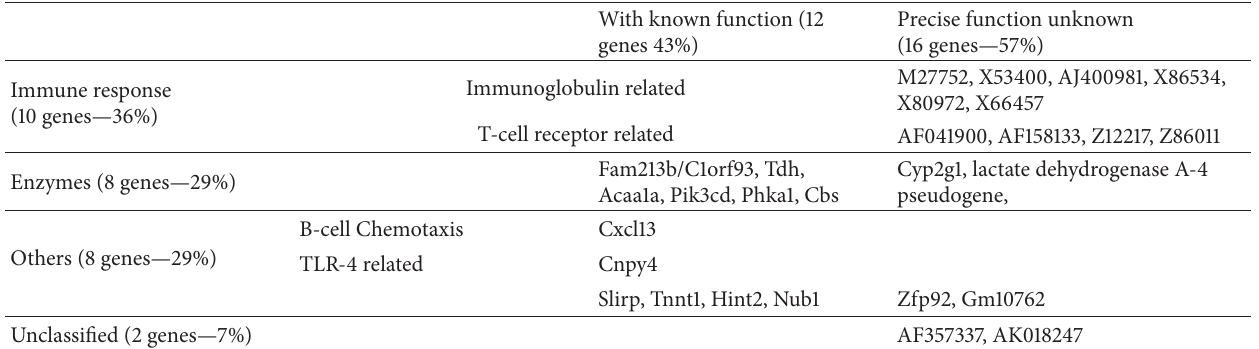
Table 2: Group analysis of genes that increase their expression in 3T3-L1 adipocytes by alliin pretreatment and after LPS